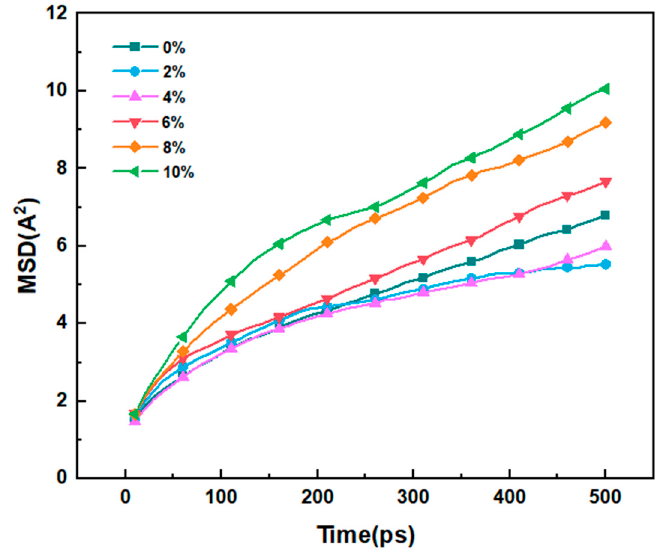
Figure 4. Mean square displacement curves of cellulose chains under different oxygen concentra- tions.